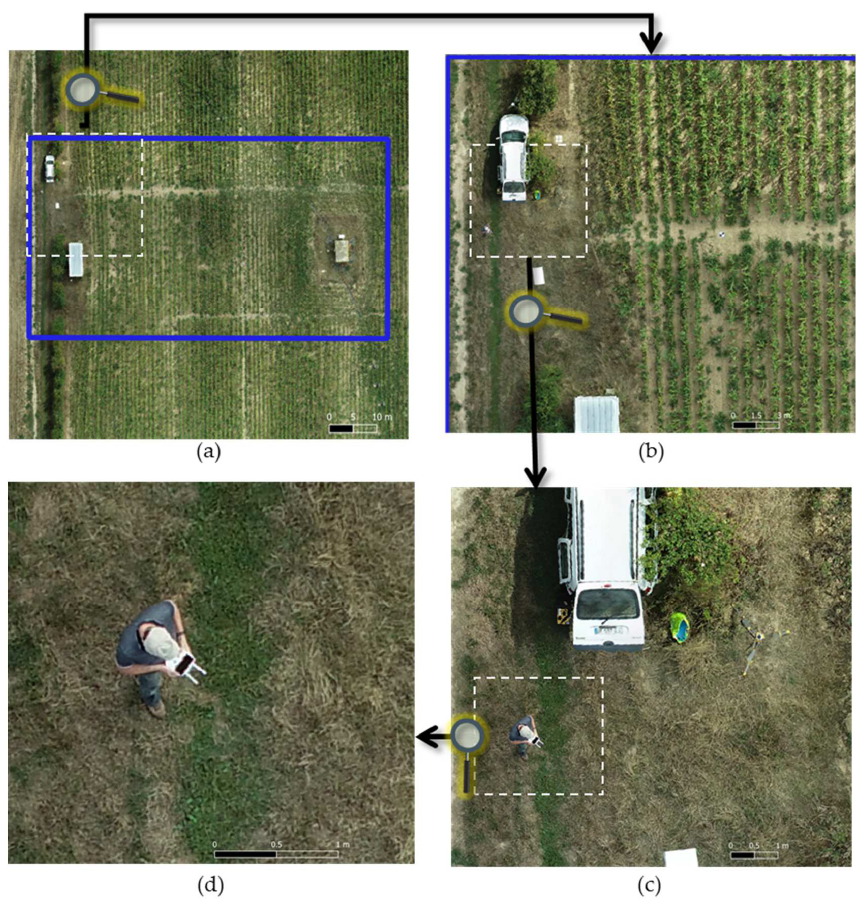
Figure 25. Final ortho-mosaic of R_6 reconstruction, 14,633 × 17,119 pixels, 0.7 cm pixel resolution, at different scales: ( a ) Whole study area scale, 75 × 75 m; ( b ) medium scale, 25 × 25 m; ( c ) car scale, 7.5 × 7.5 m; ( d ) operator scale, 2.6 × 2.6 Figure 26 shows the ortho-mosaic of the R_1 reconstruction, displayed in QGIS soft- ware, zoomed in on the 17 GCPs; the position of each target measured in the field with the Geo7x at centimeter accuracy is overlaid. All 17 targets appear to be visually very well centered on their reference positions as measured by the GNSS receiver.